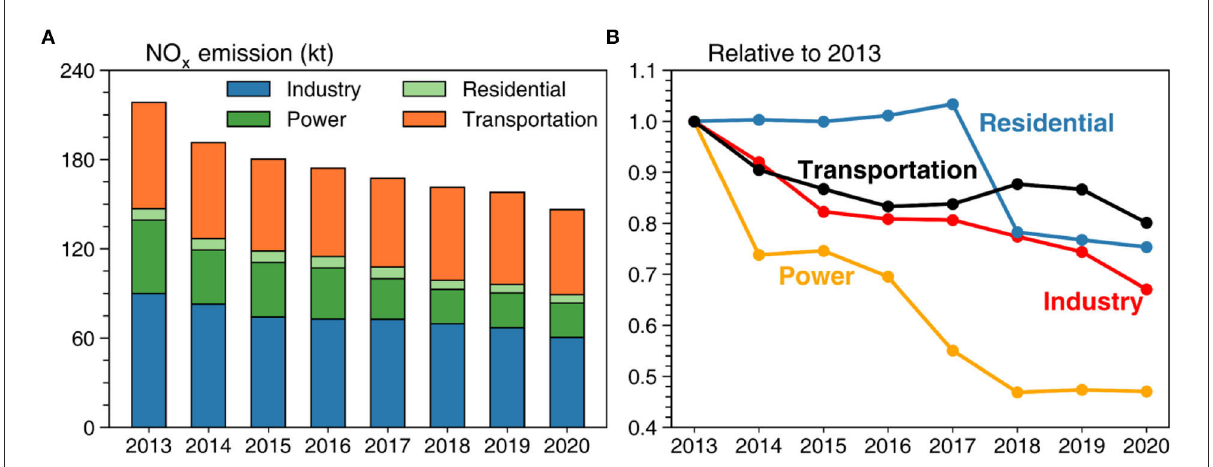
FIGURE3 Sector-based anthropogenic NO x emissions derived from MEIC inventory during warm season (April-September) from 2013 to 2020 in Jinan city.